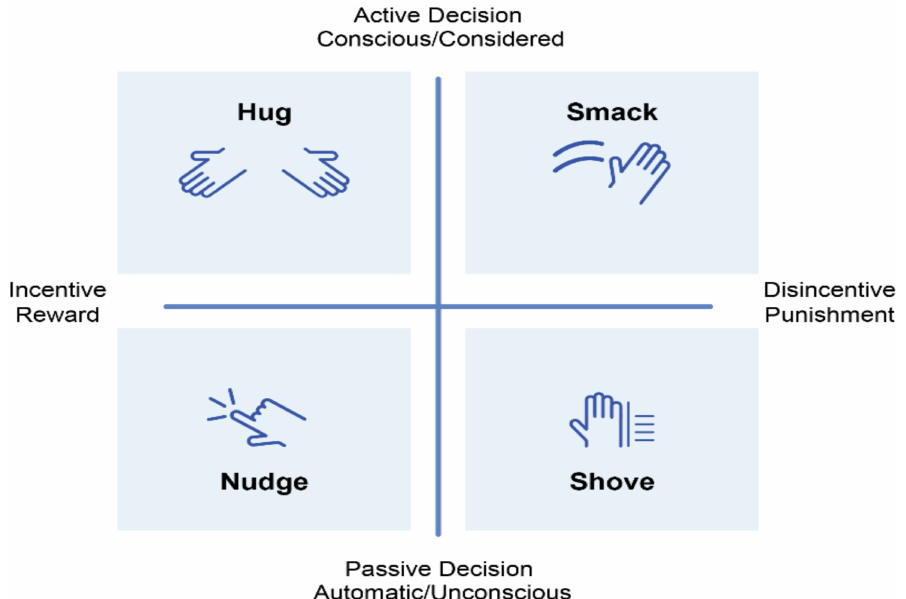
Figure 3. Reward and Incentive Scheme [32]. Copyright